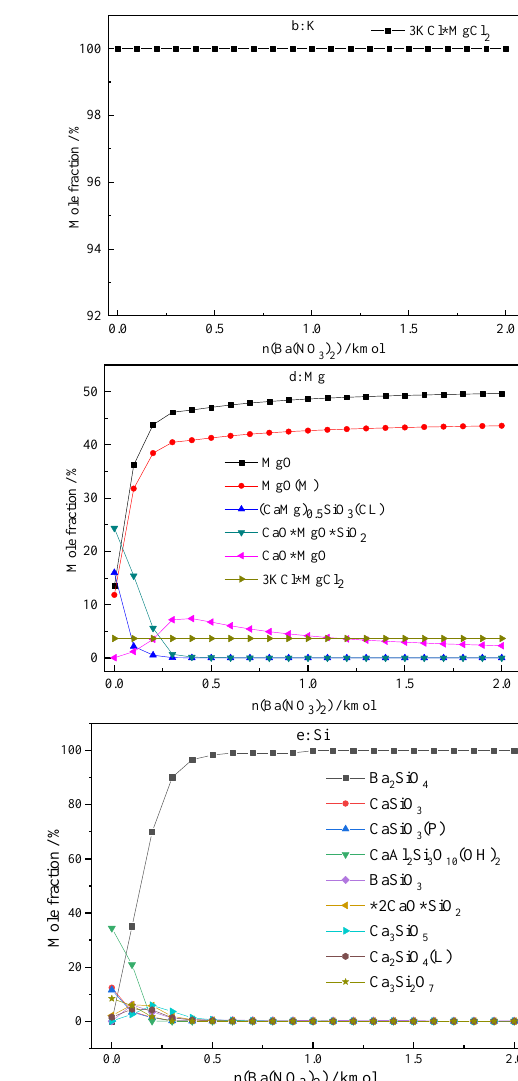
Figure 5. Effect of the amount of Ba(NO 3 ) 2 addition on the migration and transformation of main elements in ash. ( a ): Na, ( b ): K, ( c ): Ca, ( d ): Mg, ( e ): Cl, ( f ): Si. The asterisk in the chemical formula shows that the molecules or species are attached with each other as independent species, similarly hereinafter.